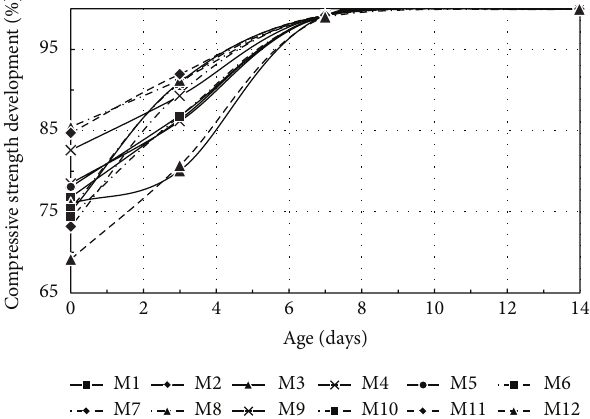
Figure 14: % of compressive strength development versus age